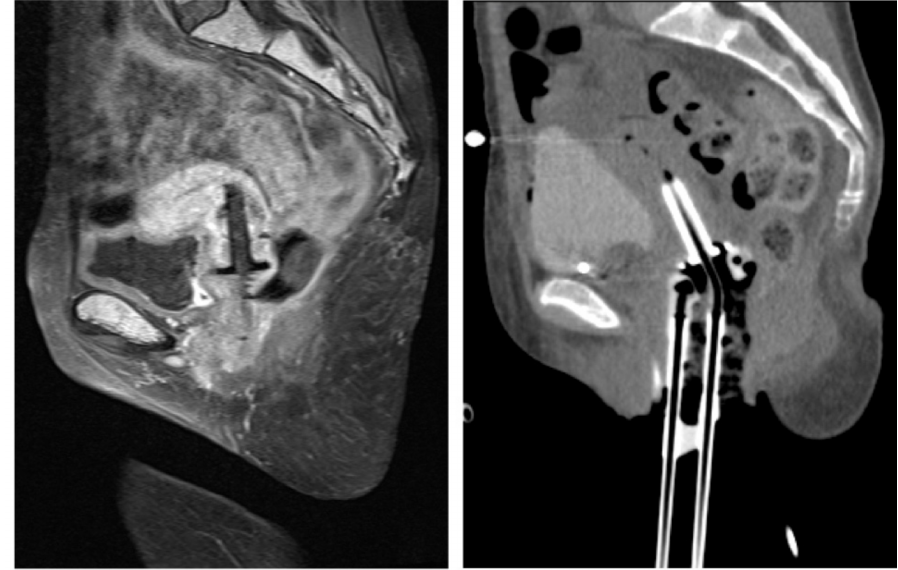
Figure 1. A uterus straightened by the insertion of the vaginal